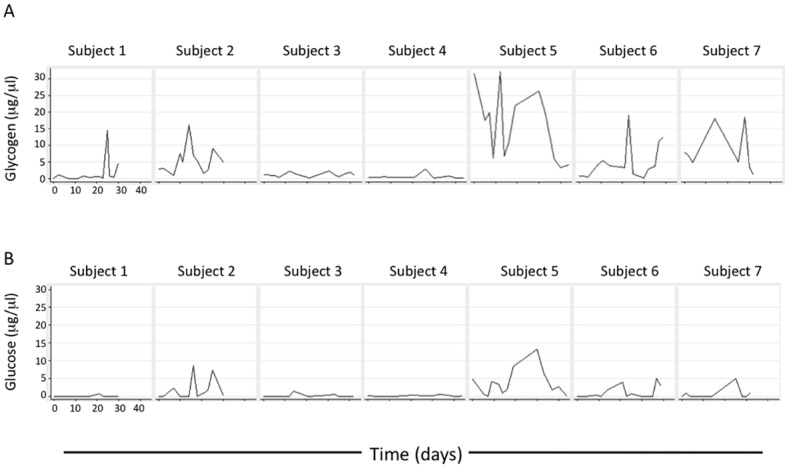
Longitudinal cell-free glycogen and glucose in undiluted vaginal secretions.Vaginal fluid was collected from seven pre-menopausal subjects using the Instead SoftCup® as described in Methods. Glycogen (A) and glucose (B) levels were measured in undiluted vaginal fluid.